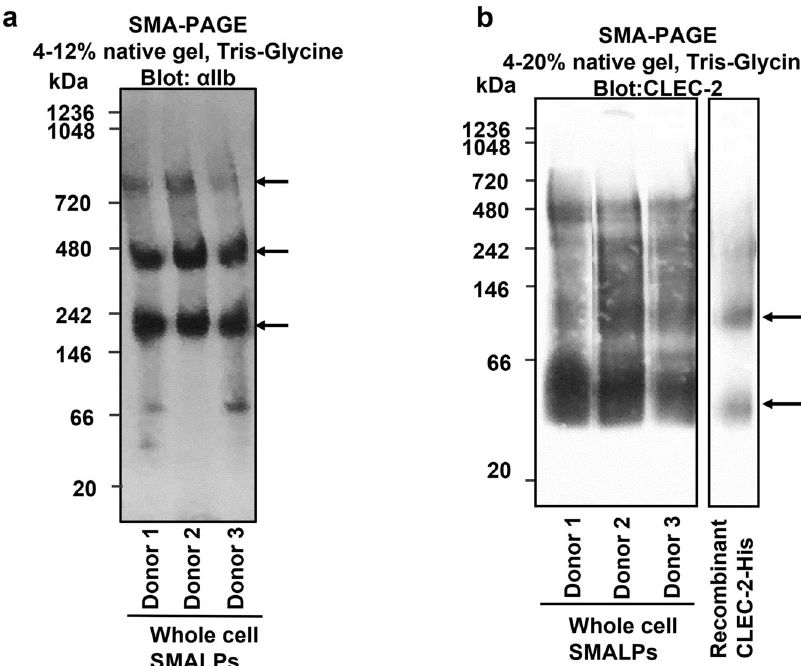
Fig. 10 α IIb β 3 and CLEC-2 blots on native PAGE with human platelet SMALP samples. Resting-state platelets from three donors were isolated and whole cell SMALPs were generated as described in methods. Platelet SMALPs were then subjected to native-PAGE (SMA-PAGE), where the negatively charged SMA belt of the nanodisc provides the migration-driven electronic force, with the gel percentage indicated. After electrophoresis, the proteins were transferred onto PVDF membrane and blotted with anti- α IIb ( a ) or anti-CLEC-2 AYP2 ( b ) antibodies. a α IIb blot on platelet SMALPs from three donors shows the existence of α IIb heterodimer and higher order oligomers. b Platelet SMALPs from three donors showed similar band patterns with a major band for platelet CLEC-2 just above the recombinant C-type lectin-like domain (Recombinant CLEC-2-His) control and a minor band for both proteins at twice the size ( n = 3 biologically independent